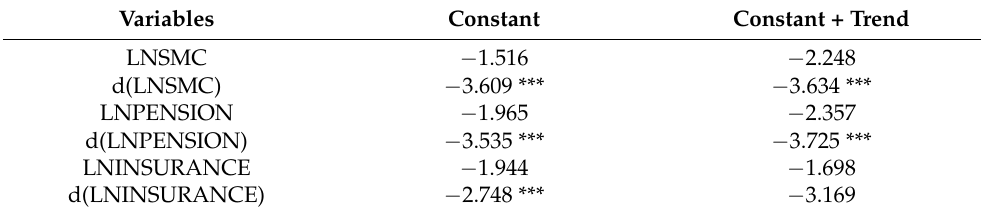
Table 3. CIPS Panel Unit Root Test Results.